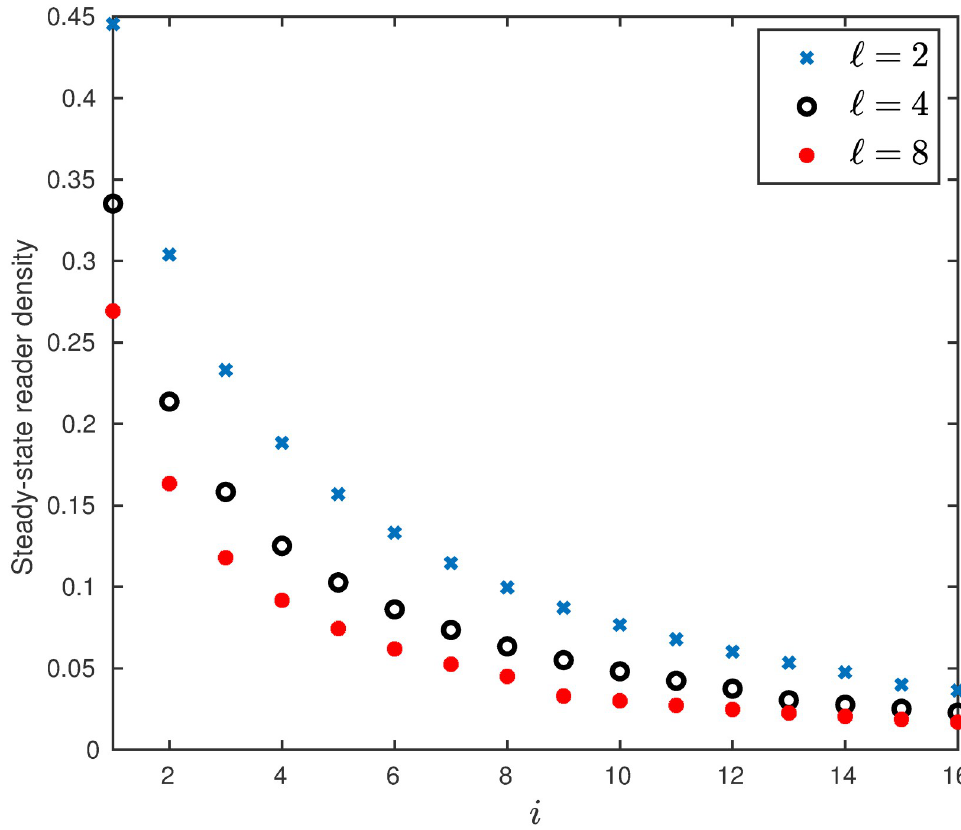
Fig 14. The steady-state reader densities as a function of i for a RFMEOD with n = 16, λ 0 = 1, λ i = 1, α i = 0.1, for i = 1, 2, ... , 16, for different values of ℓ .